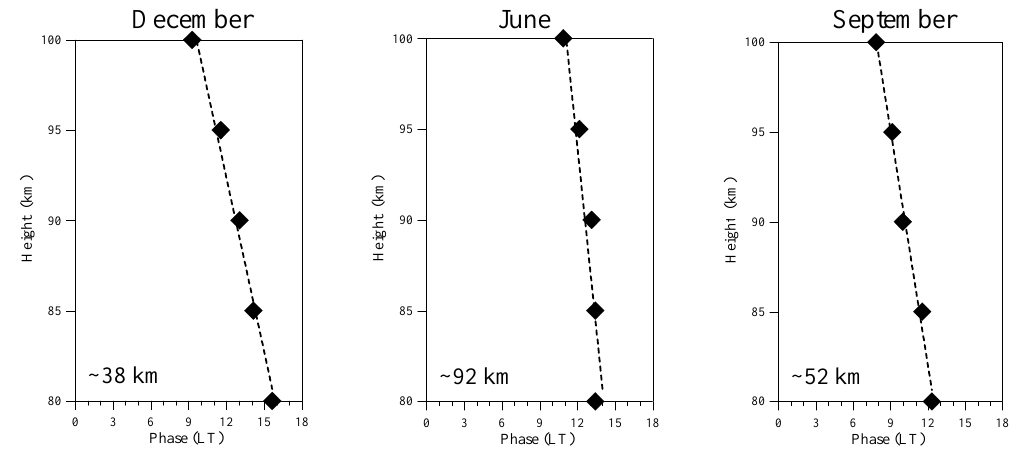
Figure 4 Fig. 4. Vertical phase profiles of the SABER semidiurnal oscillation at a geographic point (40 ◦ N, 105 ◦ W) for the months: December (left